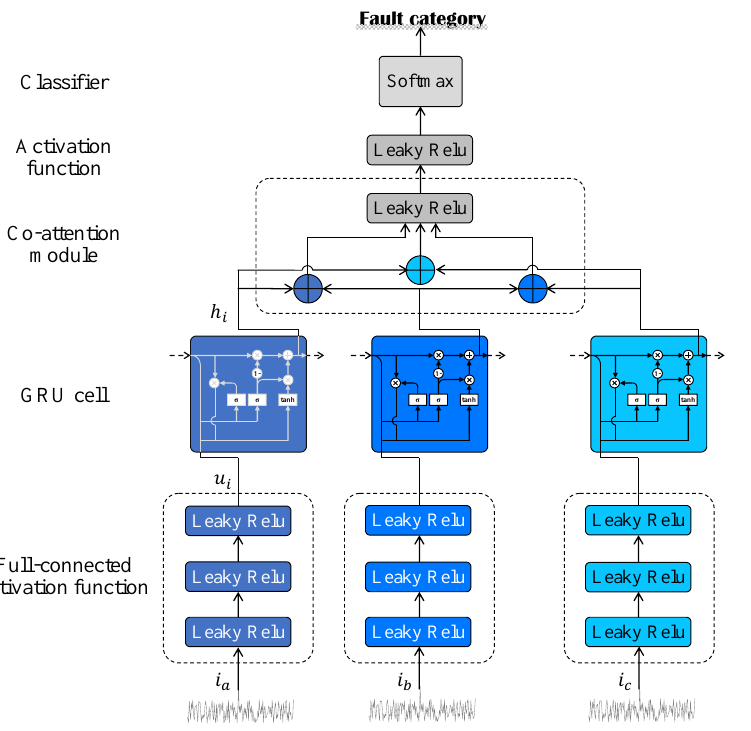
Figure 15. Fault diagnosis model architecture.